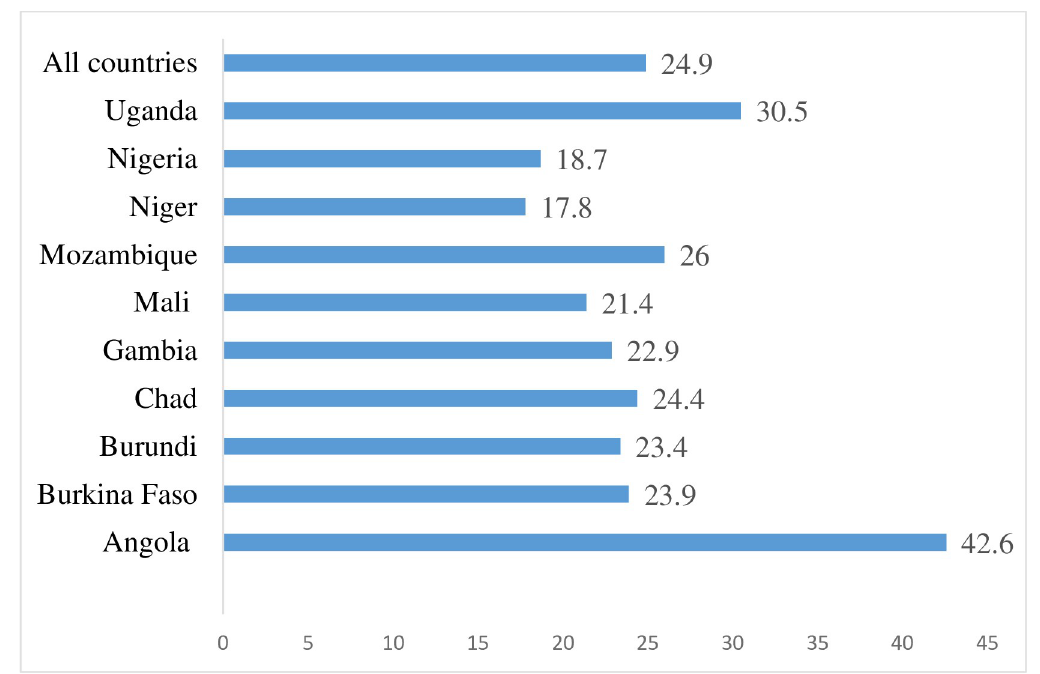
Fig 1. Prevalence of unmet need for contraception among adolescent girls and young women in selected high fertility countries in sub-Saharan Africa.